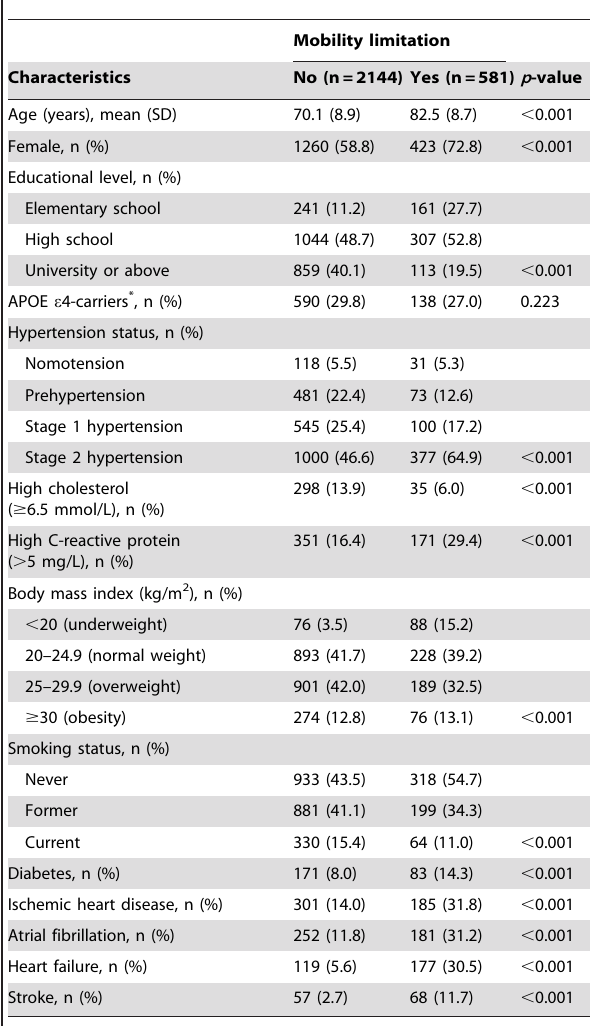
Table 1. Characteristics of the study participants by mobility status